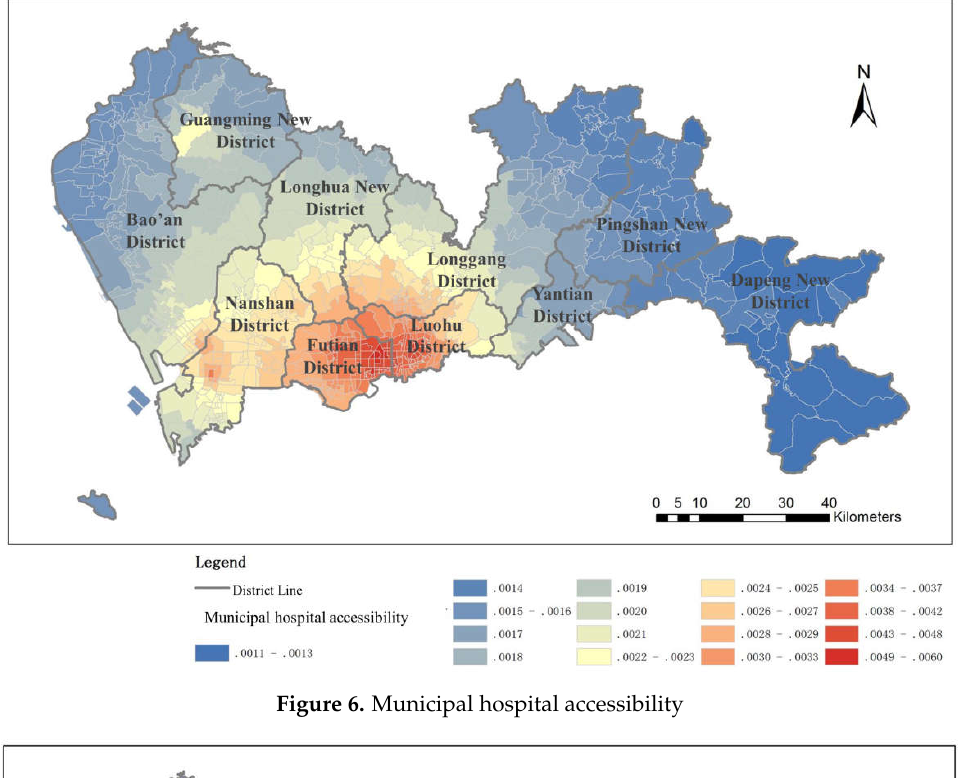
Figure 6. Municipal hospital accessibility